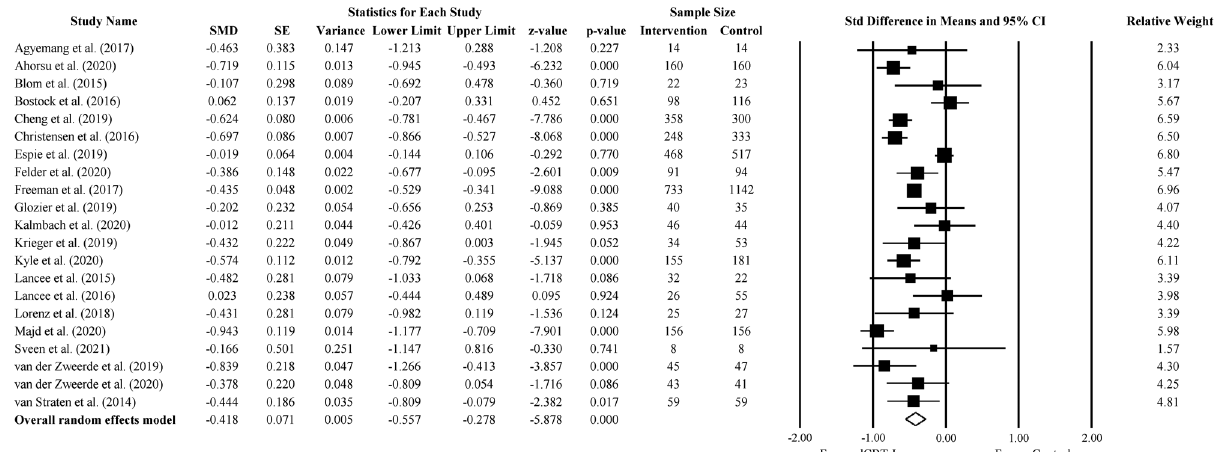
Fig. 2 The effect of dCBT-I on depression. Forest plot of studies reporting the effect of dCBT-I on depression.